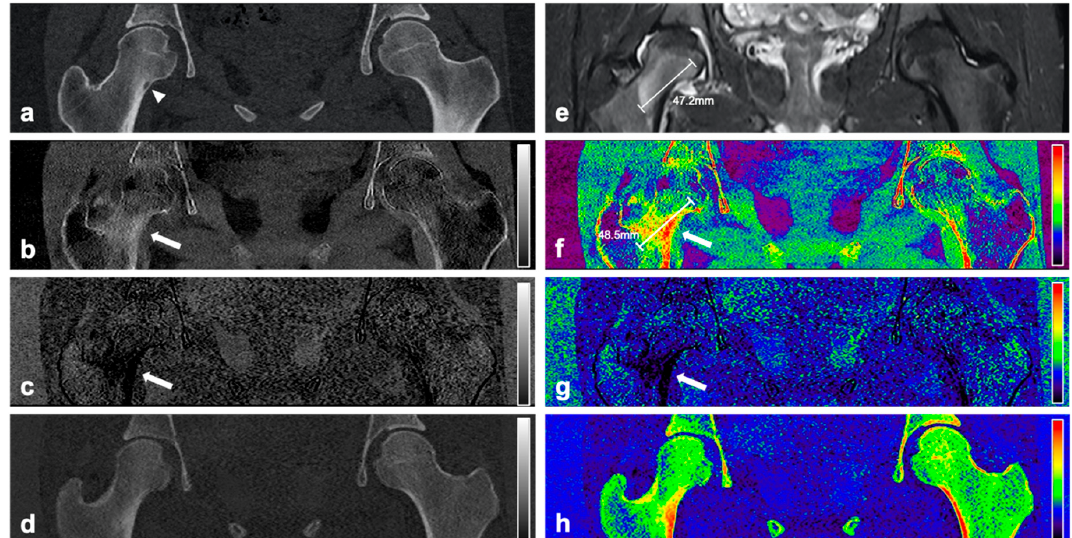
Figure 2. CT and MR images of an 18-year-old female patient with intracortical OO in the right femoral neck. Coronal reformation of the conventional CT examination ( a ) reveals the nidus in the right femoral neck with surrounding sclerosis (arrowhead). Material-specific volume fraction maps for red marrow/water ( b ), yellow marrow/fat ( c ), and hydroxyapatite ( d ), and respective color-coded overlays ( f – h ) reveal an increase in water-specific volume fraction in the red-marrow map ( b , f ; arrow) and a decrease in fat-specific volume fraction in the yellow-marrow map ( c , g ; arrow) in the right femoral neck, compared to the respective area on the other side. The corresponding coronal STIR MR image confirms the presence of a half-moon shaped edema-equivalent signal alteration in the right femoral neck around (“half-moon sign” [13] ) ( e ). Calipers indicate measurements of the extent of BME.